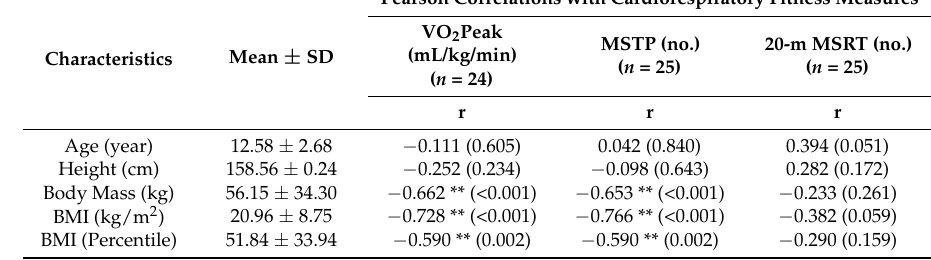
Table 1. Physiological and anthropometric characteristics of study participants and correlations with cardiorespiratory fitness measures.